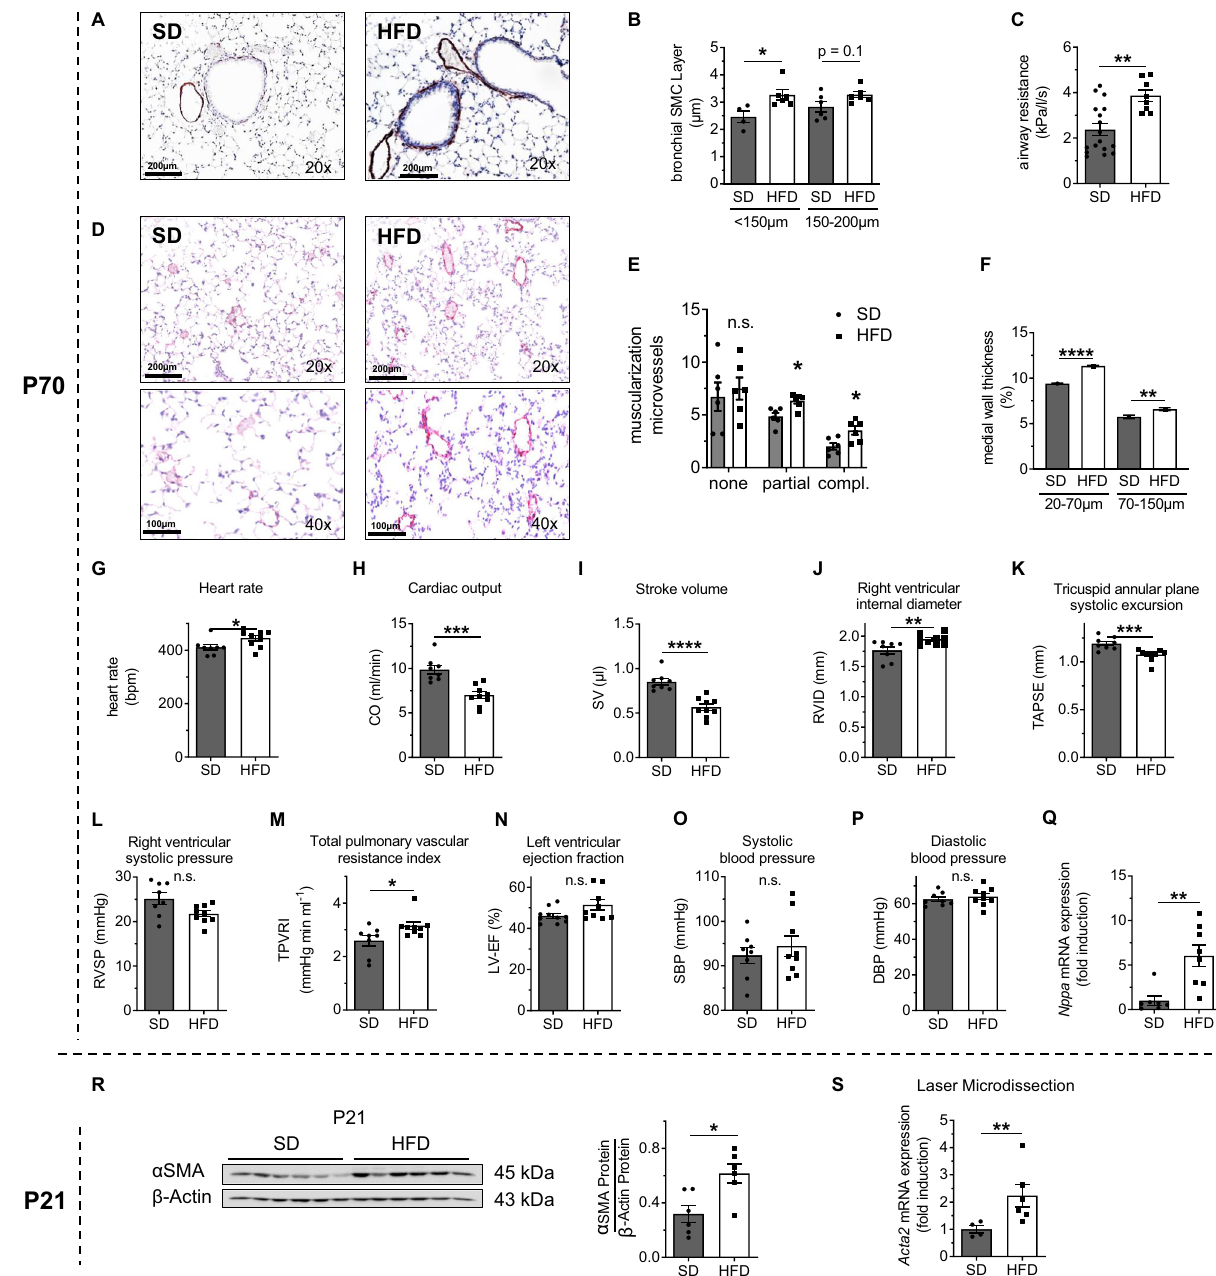
Fig. 2 A maternal high-fat diet (HFD) is associated with thickening of the bronchial and vascular smooth muscle cell (SMC) layer as well as bronchial obstruction and pulmonary arterial hypertension beyond infancy. A Representative images of the lungs of offspring at postnatal day 70 (P70). Immunohistochemistry for α -smooth muscle actin ( α SMA) was performed to assess the bronchial SMC layer in the offspring of dams fed a HFD or standard diet (SD). B Quantitative measurement of the bronchial SMC layer in bronchi with diameters <150 µ m and 150 – 200 µ m. C Assessment of respiratory airway resistance using body plethysmography at P70. D – F Representative images of the lungs of offspring at P70. Dual staining for α SMA and von Willebrand factor (vWF) ( D ) was used to assess the muscularization of microvessels (20 – 100 µ m) ( E ) and the medial wall thickness of microvessels